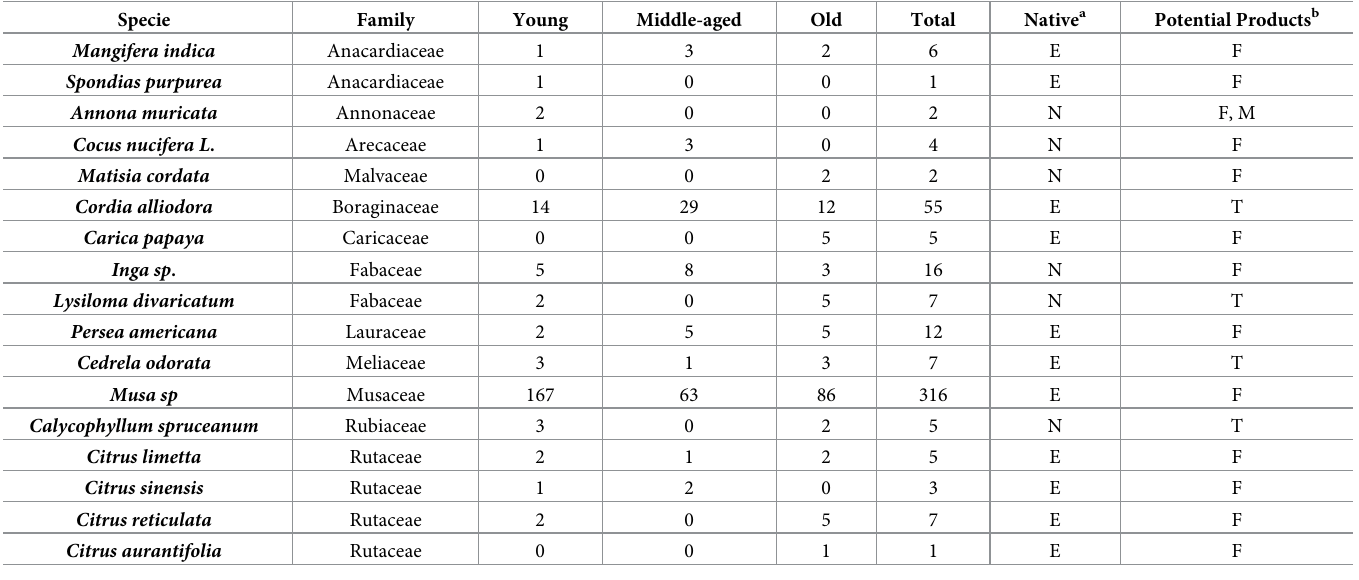
Table 4. Species and abundance according to the age of AFS and in a total. And the potential products that can be exploited from them. (E = Exotic; N = Native; F = Forest; M = Medicinal; T =